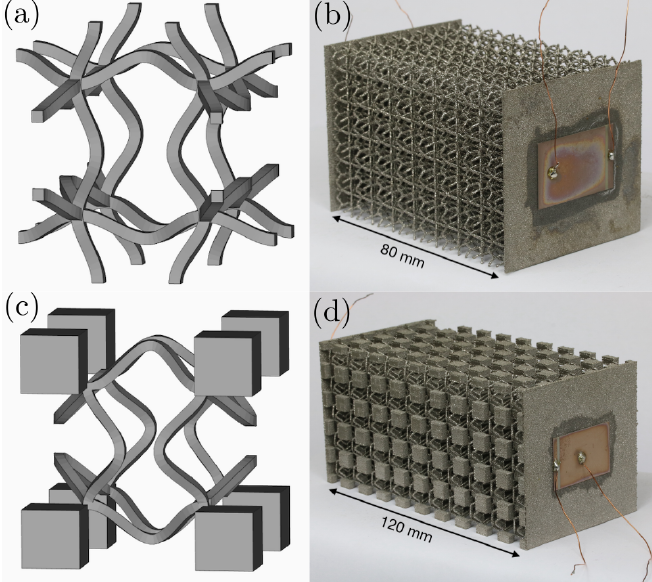
Figure 1. CAD view of unit cell for ( a ) sample 1 and ( c ) sample 2. Photograph of manufactured ( b ) sample 1 with 5.5 × 5.5 × 8 unit cells and a unit cell edge length of 10mm and ( d ) sample 2 with 5 × 5 × 10 unit cells and a unit cell edge length of